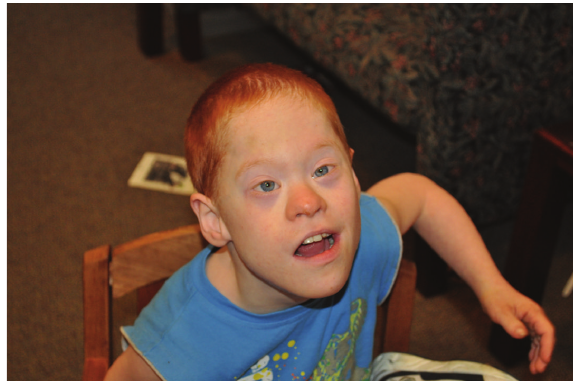
Figure1:BoywithcooccurrenceDSandfullmutationFXS.Features include dolichocephaly, epicanthal folds, and upslanting palpebral